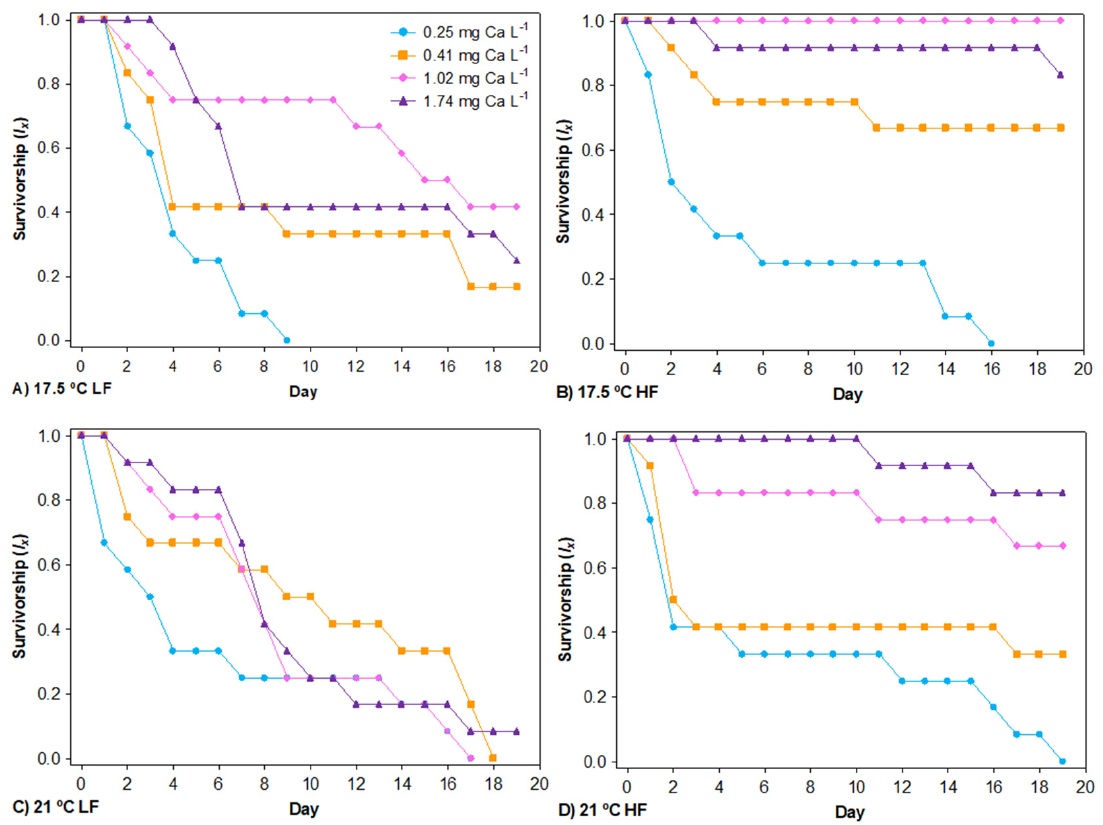
Figure 3. The age − specific survivorship (l x ) of D. pulex when reared across a calcium gradient at two temperatures (17.5 °C and 21 °C) and two food levels (LF [low food] and HF [high food]) over a period of 19 days.